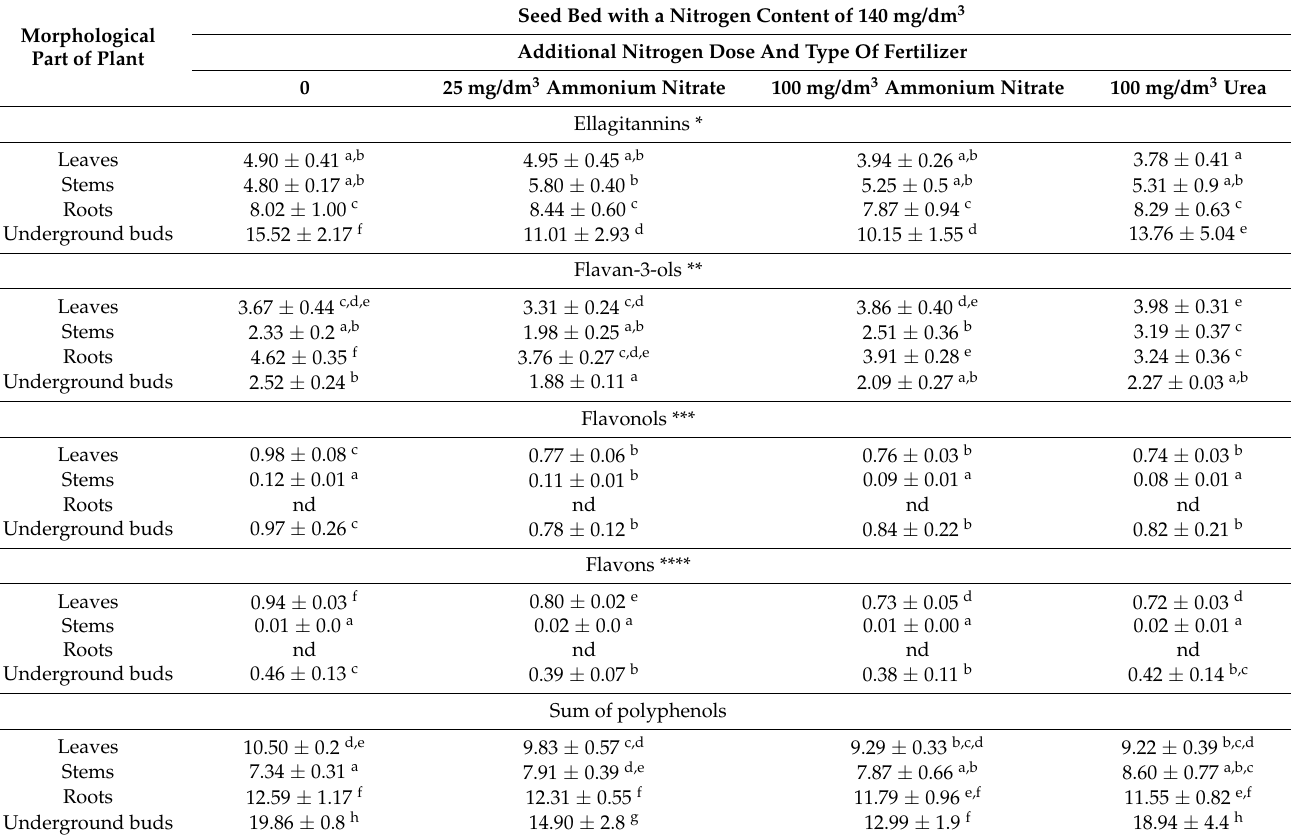
Table 3. The content of main polyphenol groups (g/100 g DM) in various morphological parts of fragrant agrimony Agrimonia procera Wallr. From experimental